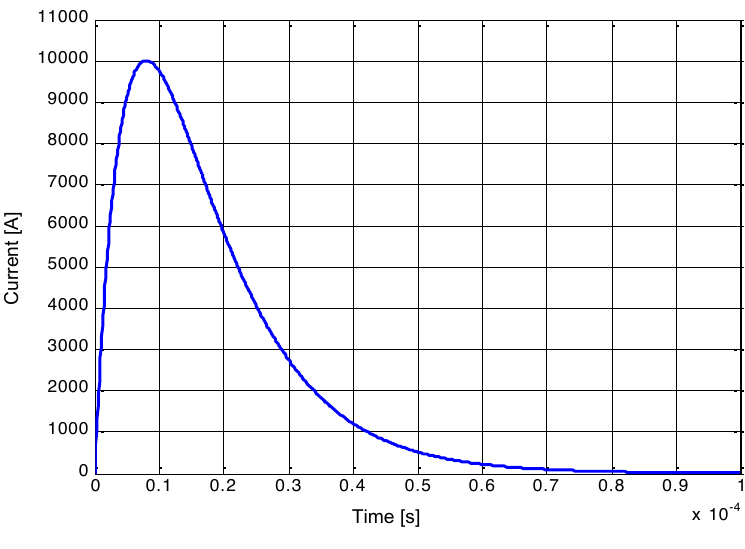
Fig. 5. The discharge current of 10 kA with impulse shape 8/20